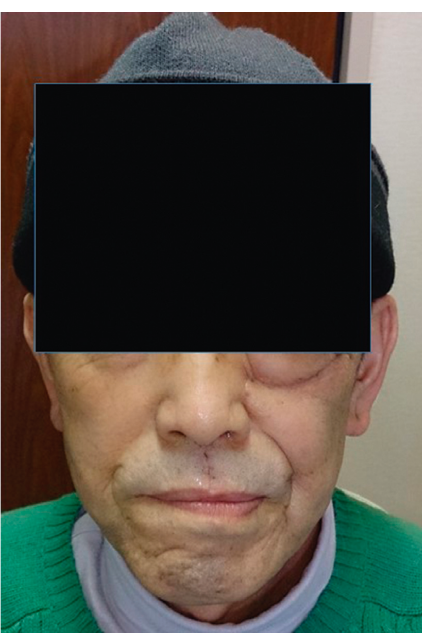
Figure 5: Frontal view two months after